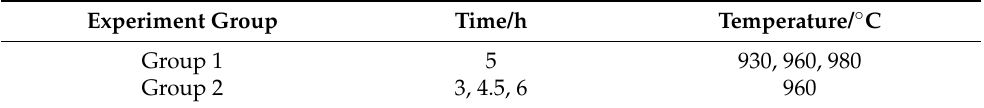
Table 1. Process parameters of salt bath